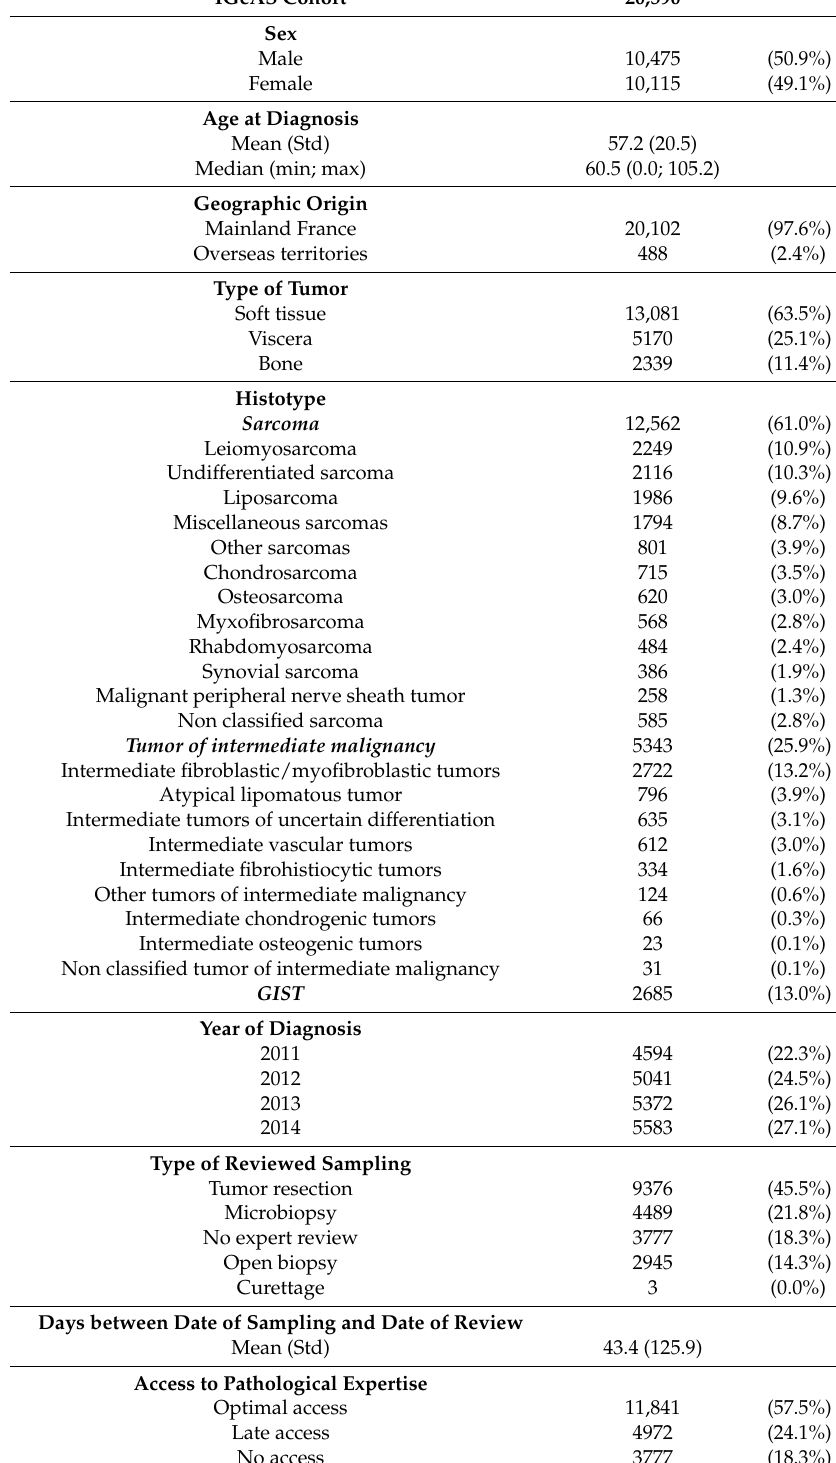
Table 1. Description of the IG é AS